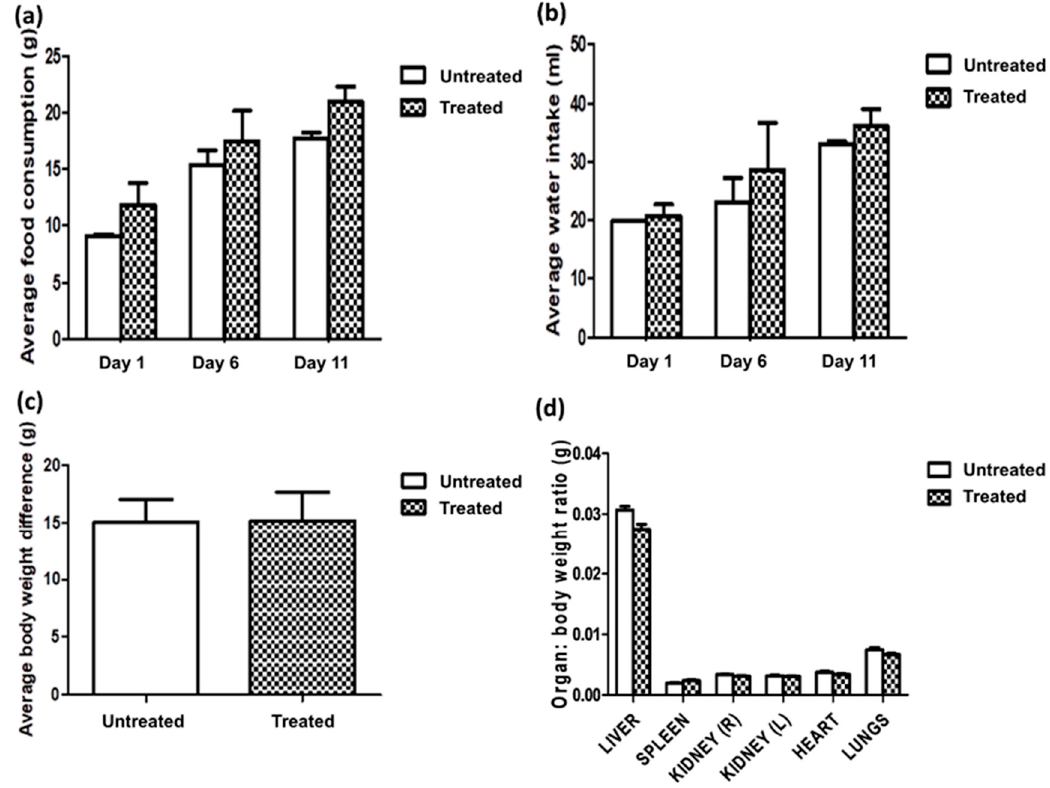
Figure 1. ( a ) Average food consumption, ( b ) average water intakes, ( c ) average body weight and ( d